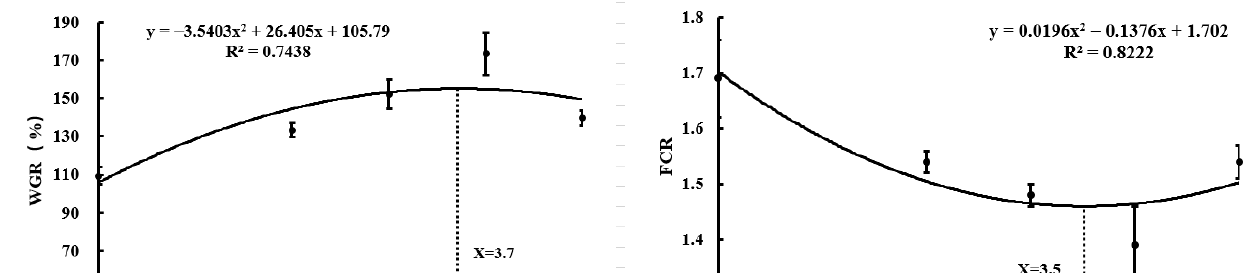
Figure 1. The quadratic regression between dietary CAs supplementation levels and WGR ( A ) or FCR ( B ).